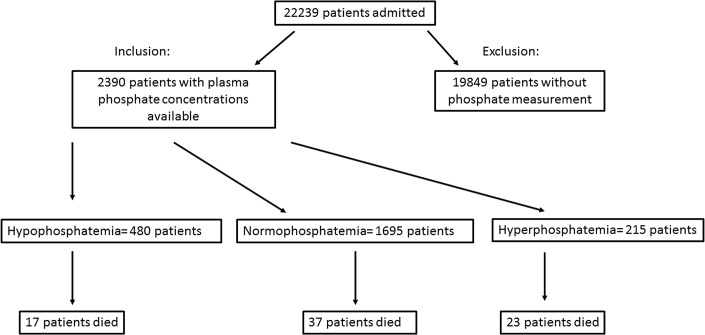
Patient flow chart.